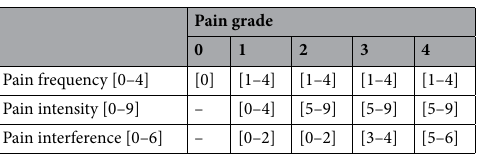
Table 1. Operationalization of the chronic pain grade scale in the current